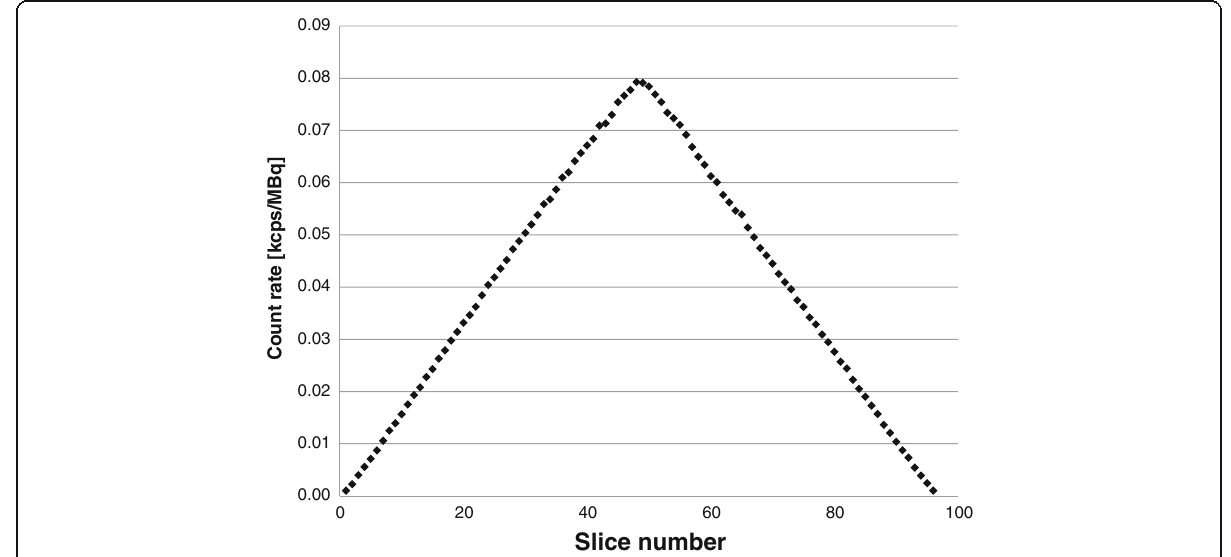
Fig. 2 The axial sensitivity profile with the line source placed at the center of the